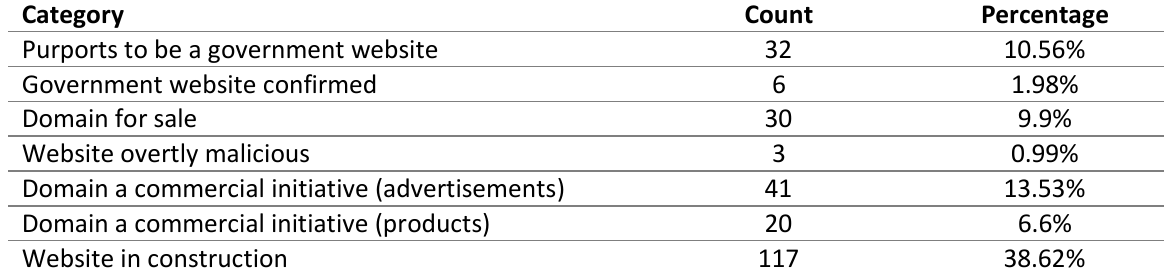
Table 1. Percentage of surveyed websites per category